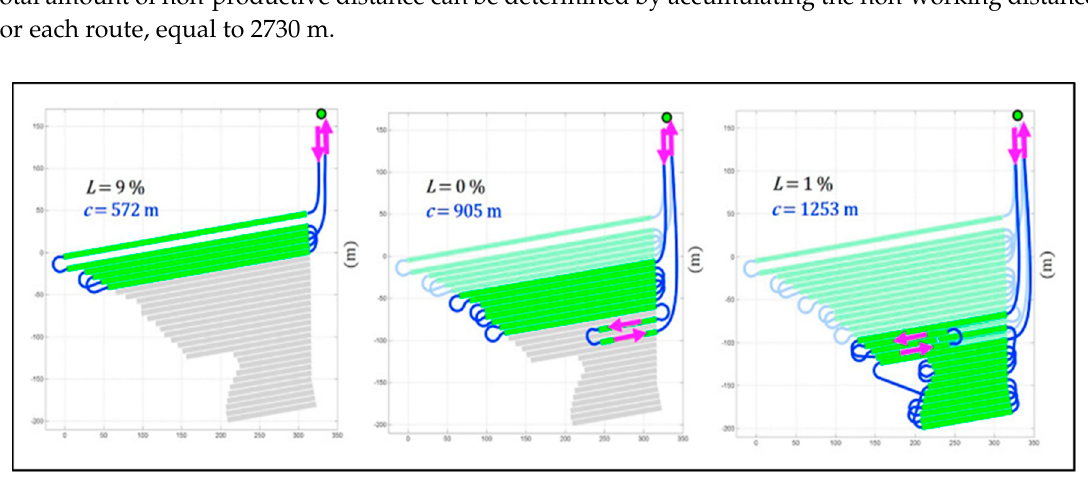
Figure 11. The coverage plan for operation A [26].